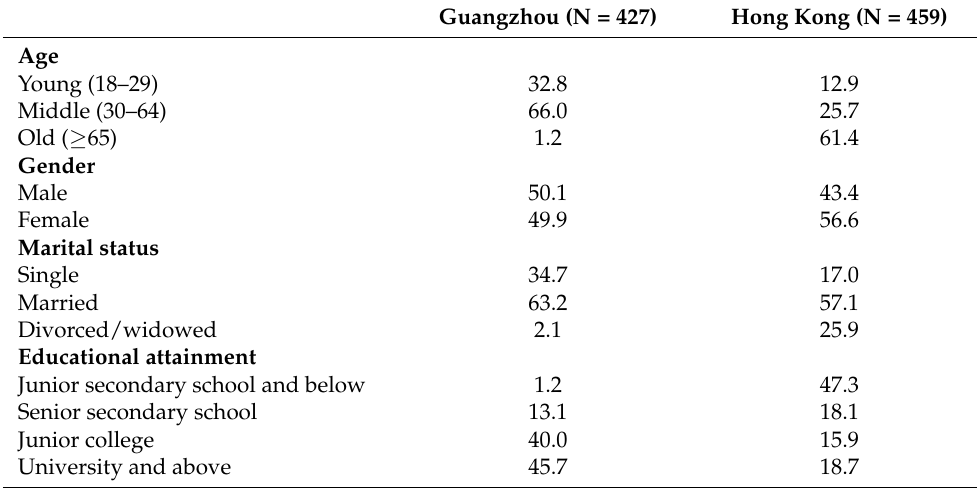
Table 1. Statistics of the whole samples